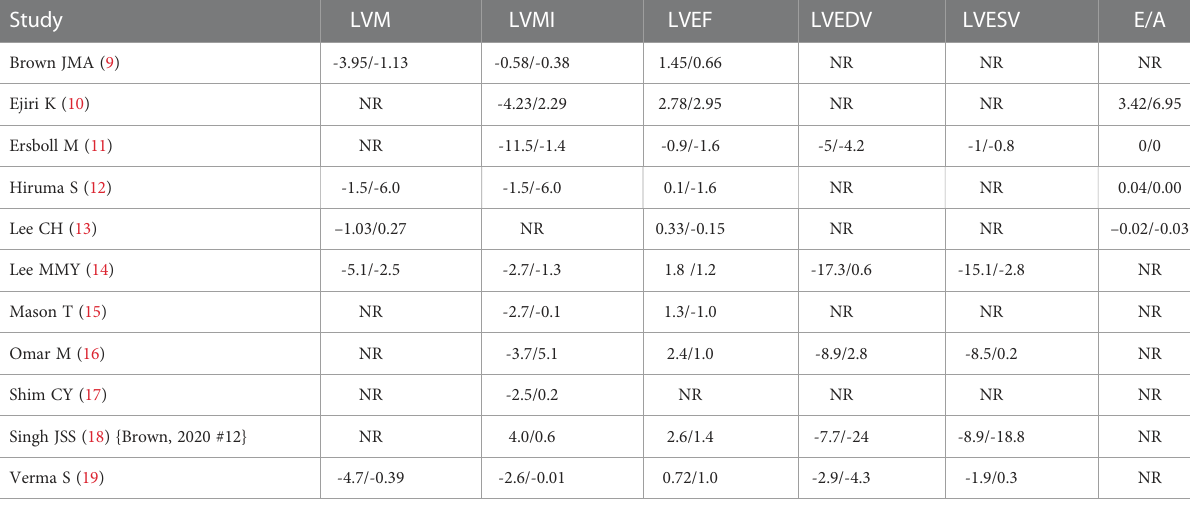
TABLE 2 The outcome changes of 11 included studies.